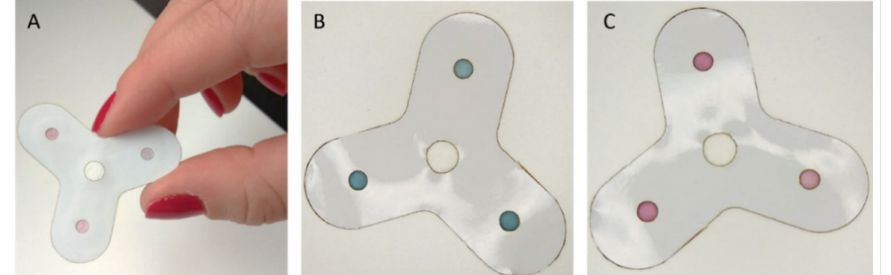
Figure 7. ( A ) Photograph of the final device embedded in the PVC mask with, representative of its real size. ( B , C ) Images of the proposed prototype with the specific mask after the assay on saliva spiked with the three analytes at the beginning of the test ( B ) and after 10 min of reaction ( C